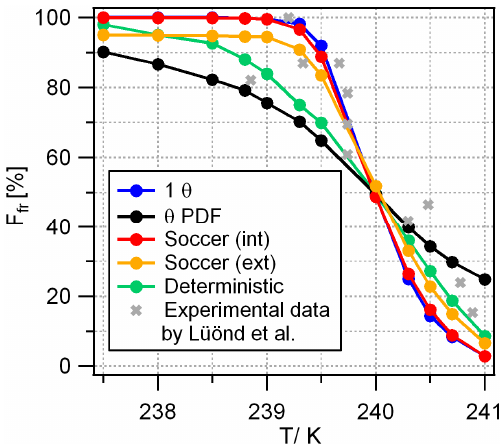
Fig. 2. Predicted frozen fraction F fr as a function of temperature Figure 2. Predicted frozen fraction F fr as a function of temperature from box model calculations 2 from box model calculations and experimental data by L¨u¨ond et al. (2010) after 14s simulation time and at S w = 0 . and experimental data by Lüönd et al., (2010) after 14 s simulation time and at S w = 0.2%. 3